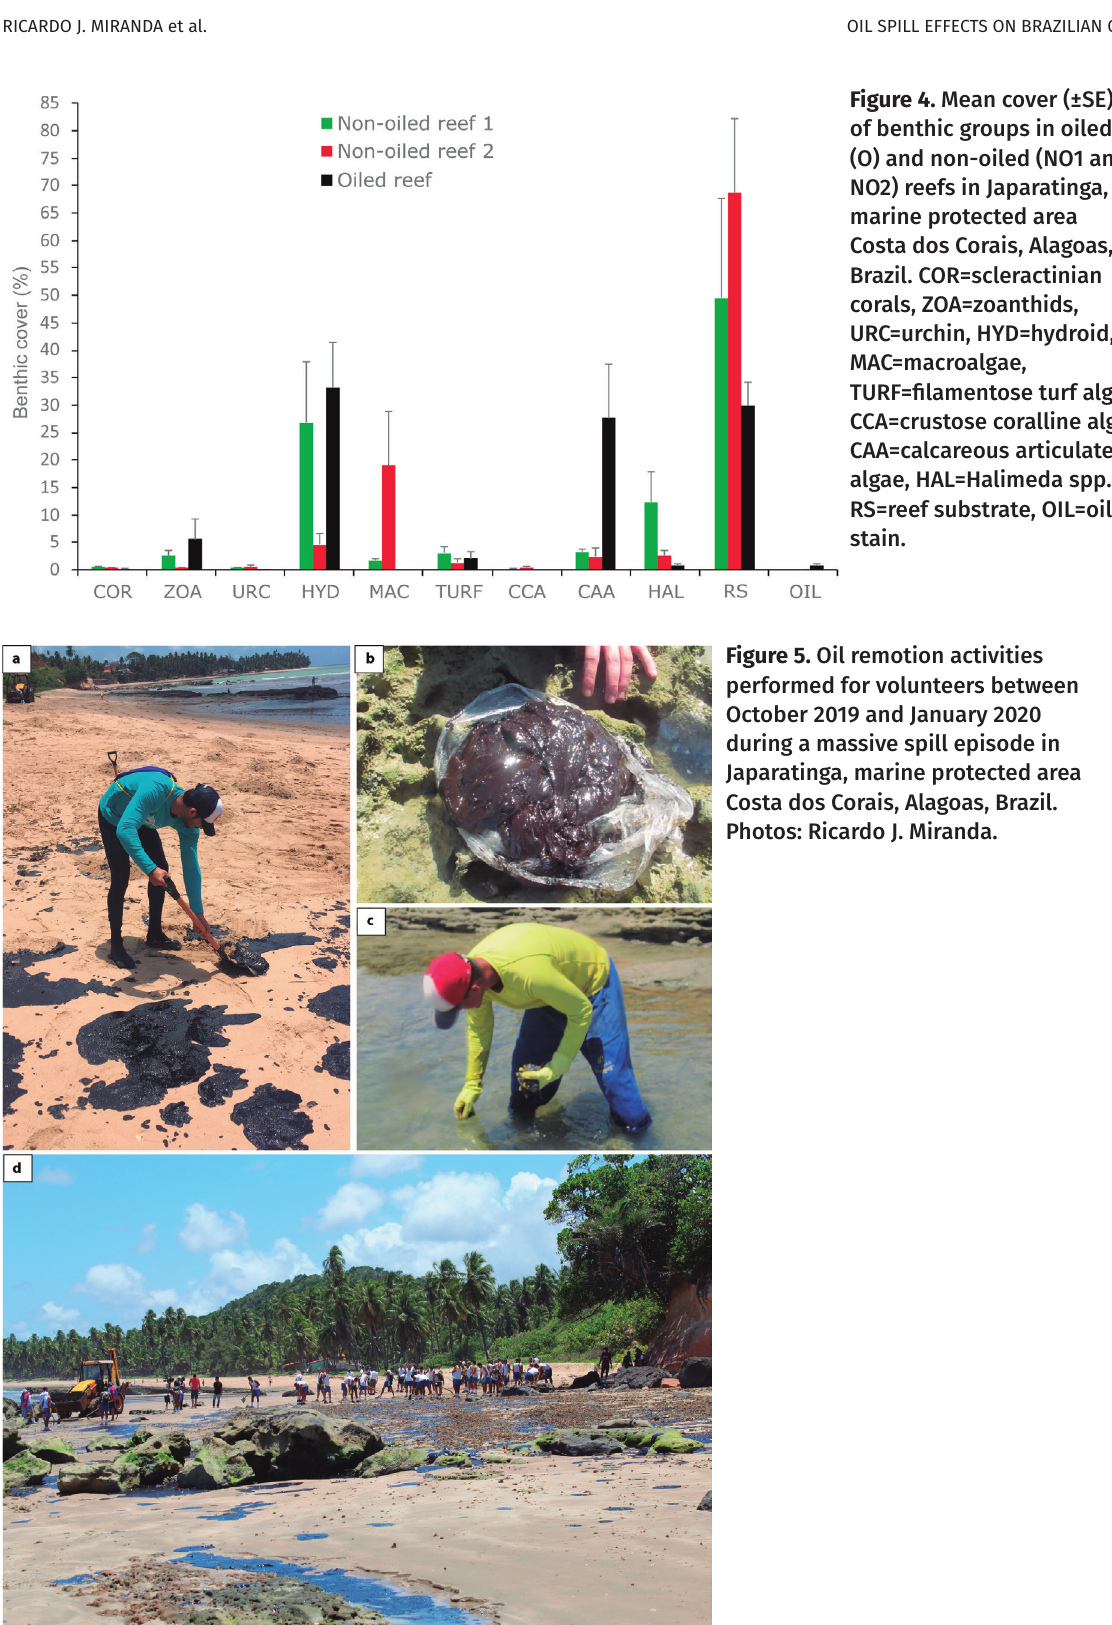
marine protected area